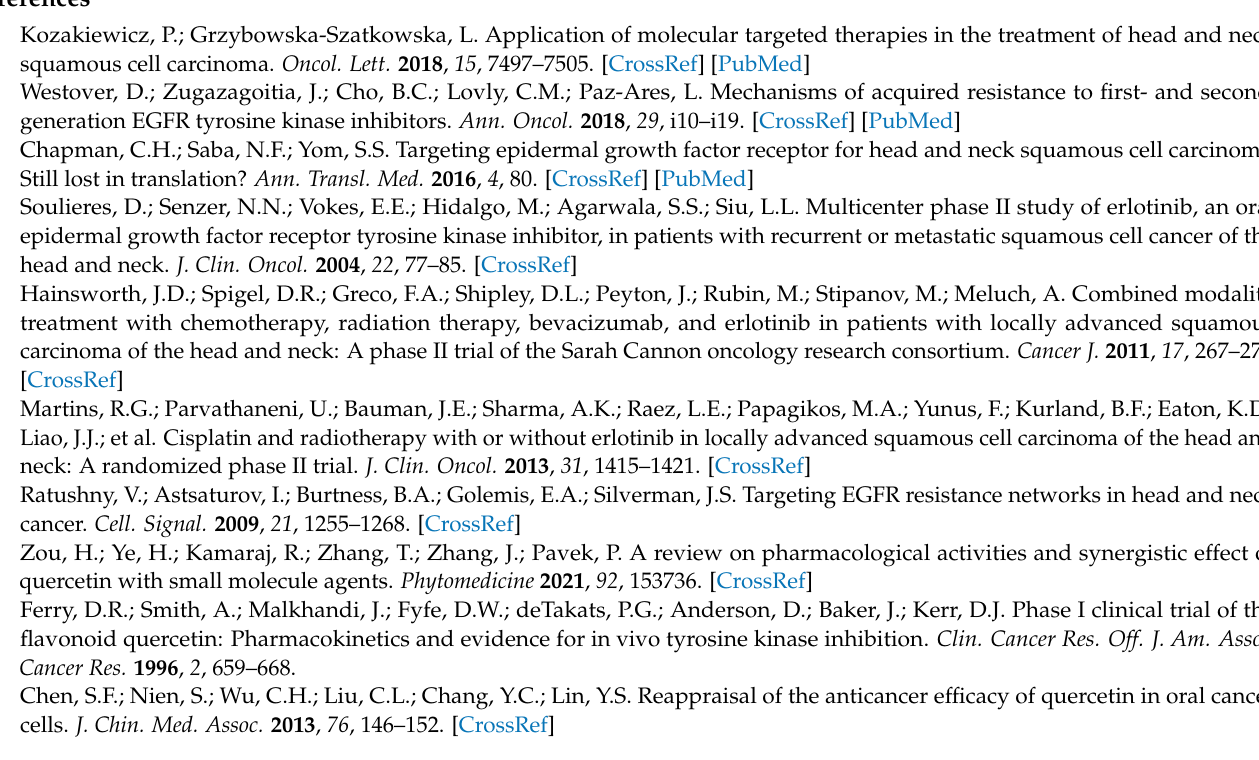
Figure S2: GLUT1 (SLC2A1) expression in the HNSCC (Head and Neck squamous cell carcinoma) dataset of the Cancer Genome Atlas (TCGA) project; Figure S3: PKM2 mRNA expression positively correlates with glycolytic enzyme genes in an HNSCC (Head and Neck squamous cell carcinoma) dataset of the Cancer Genome Atlas (TCGA) project; Figure S4: PKM2 mRNA expression positively correlates with matrix metalloproteinase (MMP) genes in an HNSCC (Head and Neck squamous cell carcinoma) dataset of the Cancer Genome Atlas (TCGA)